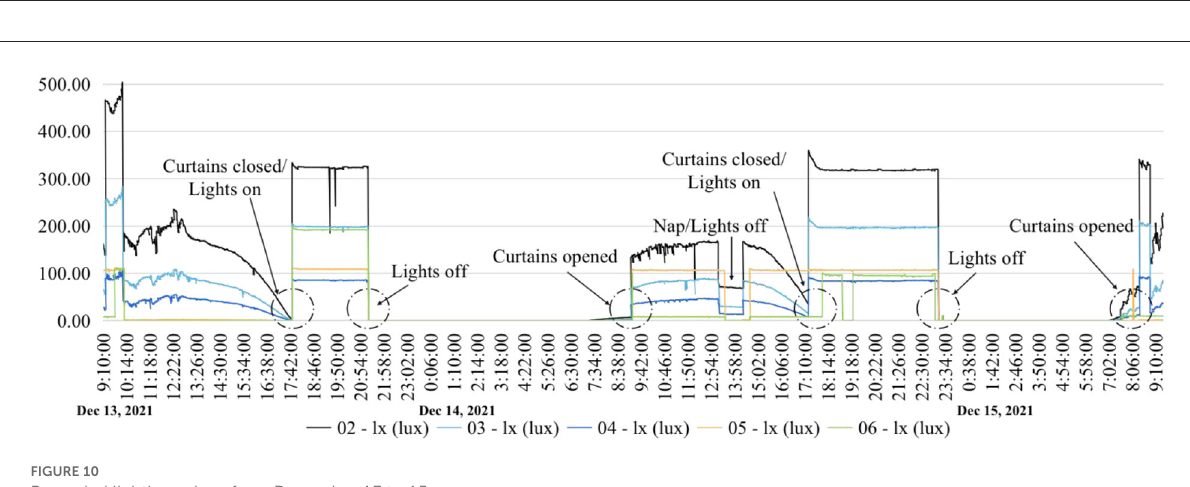
FIGURE10 Recorded lighting values from December 13 to